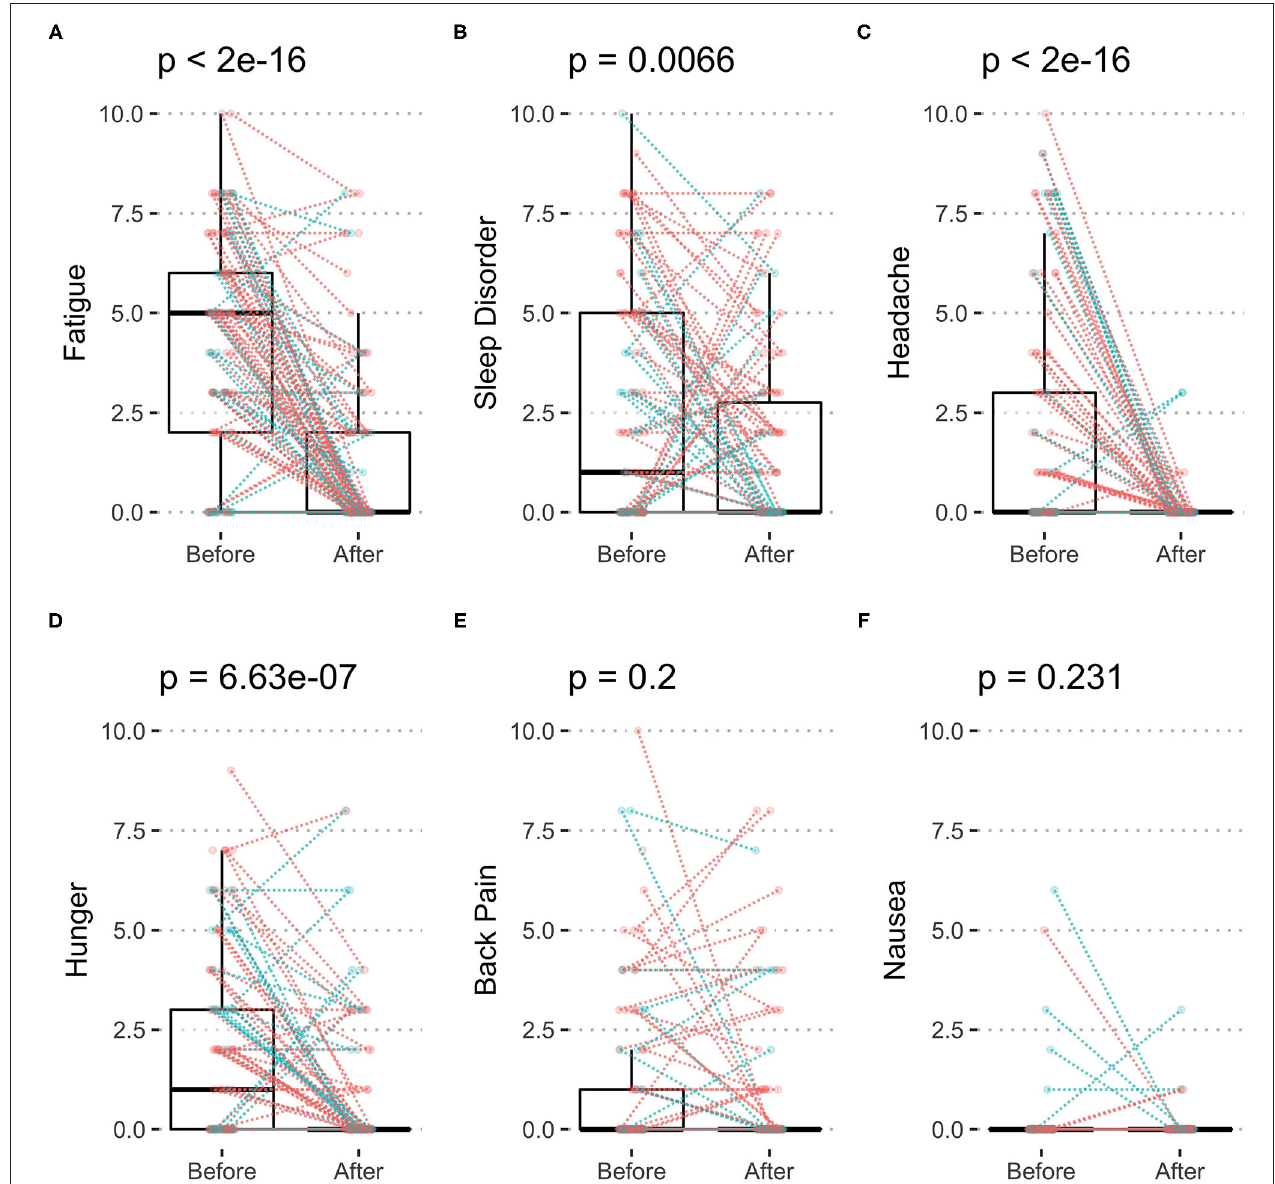
FIGURE 3 | Symptoms of body discomfort before and after 10-days fasting. The individual changes (women in red and men in blue) as well as box plots indicating median and quartiles are presented for fatigue (A) , sleep disorder (B) , headache (C) , hunger (D) , back pain (E) , and nausea (F) .